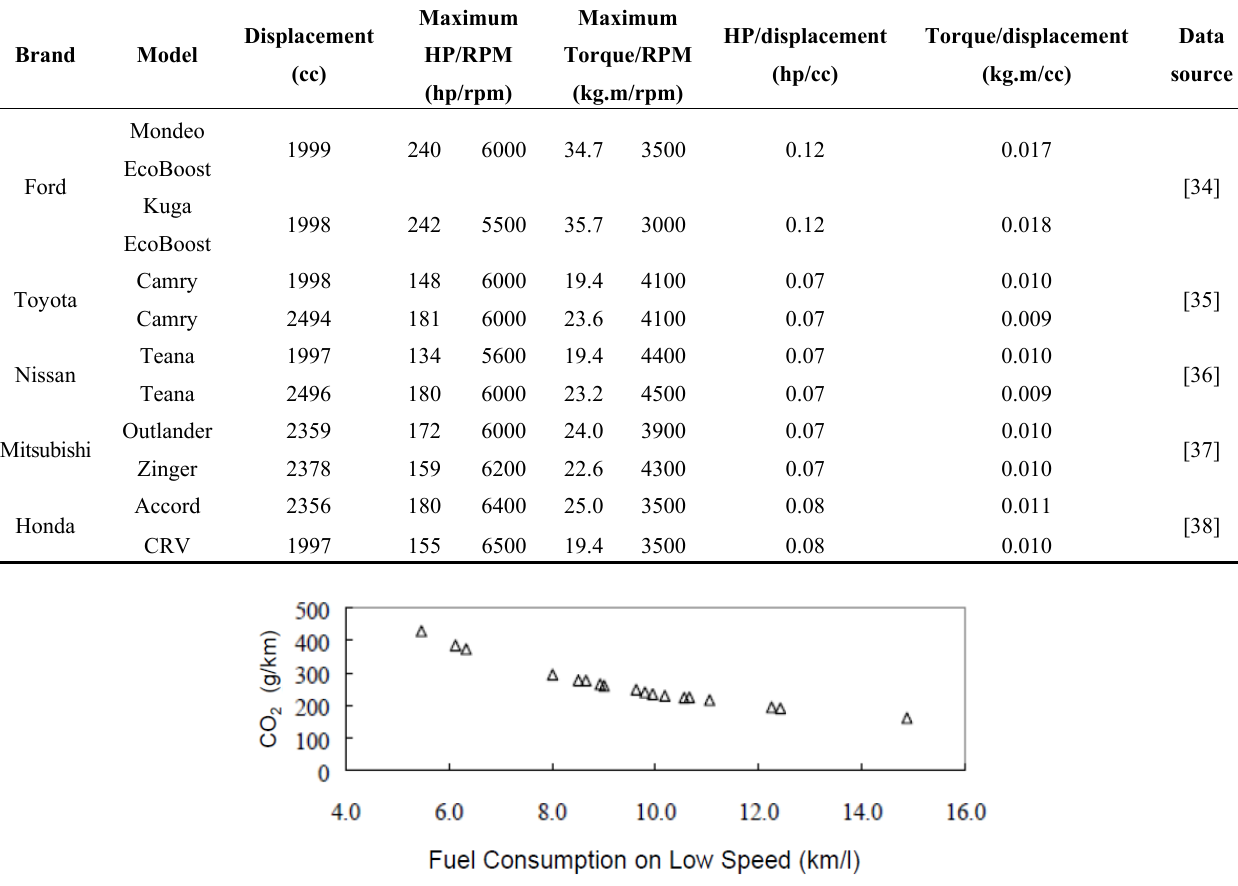
Table 1. The comparison of engine displacement vs. horsepower and torque in local market. Data source: Ford, Toyota, Nissan, Mitsubishi, and Honda official website [34–38].